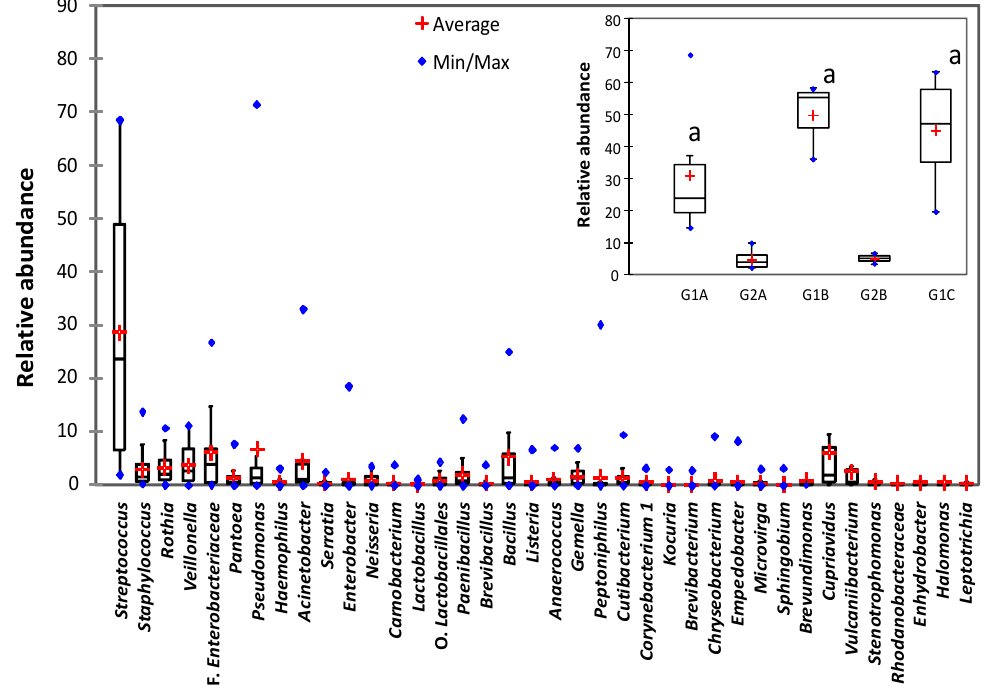
Figure 2. Box-plot representation of the relative abundances of the 38 main bacterial genera detected in the milk samples. Insert: Box-plot representation of the relative abundances of gen. Streptococcus during the sampling period. Data were grouped by weeks according to relative abundance. Groups with high relative abundance: G1A (weeks 1–4, 6–7), G1B (weeks 14, 16–17), G1C (weeks 21–25,